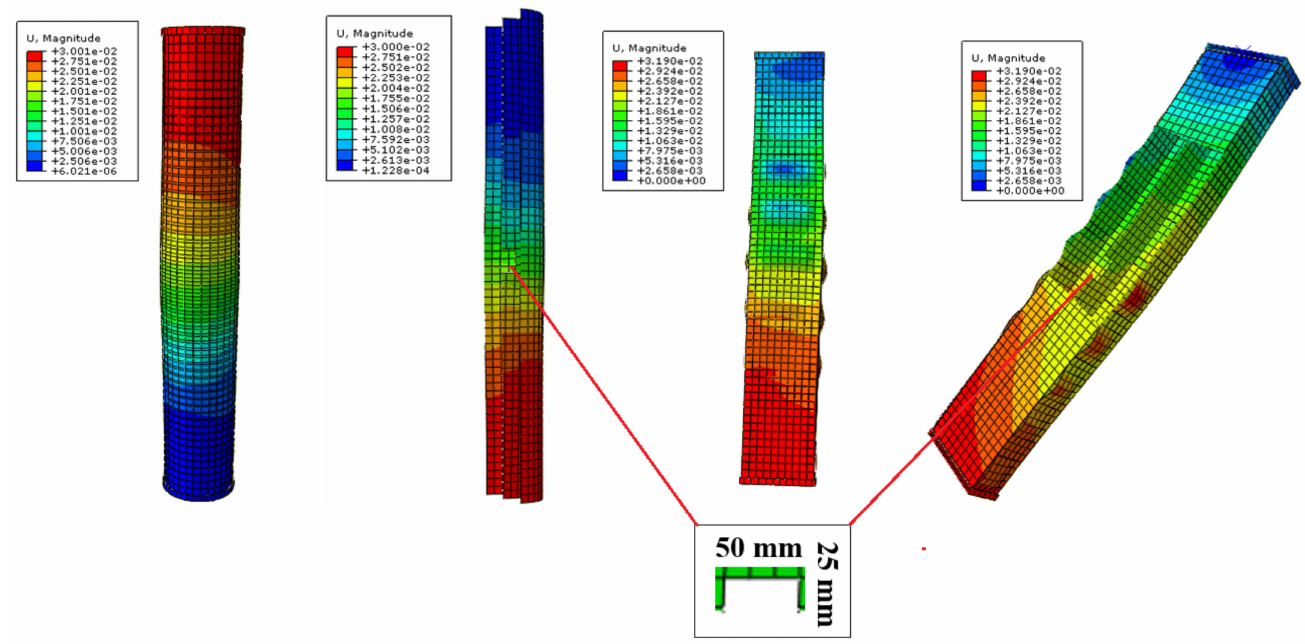
Figure 11. The contour of deflection of CCFST and SCFST columns having 1 mm cross-shaped plate with